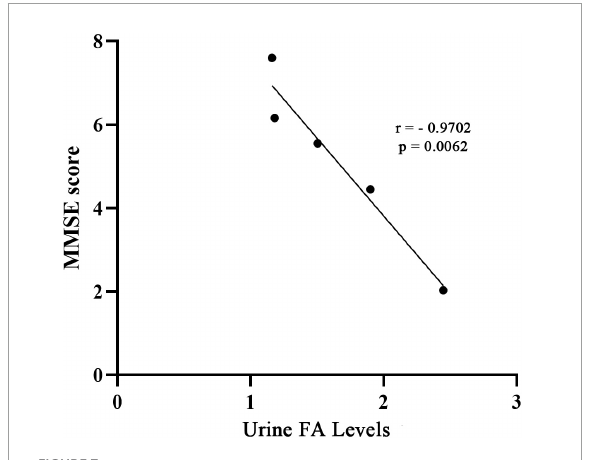
FIGURE7 Correlation between urine FA levels and MMSE score. The concentration of FA in urine was negatively correlated with MMSE score ( r = –0.9702, p = 0.0062). MMSE, mini-mental state examination; FA,